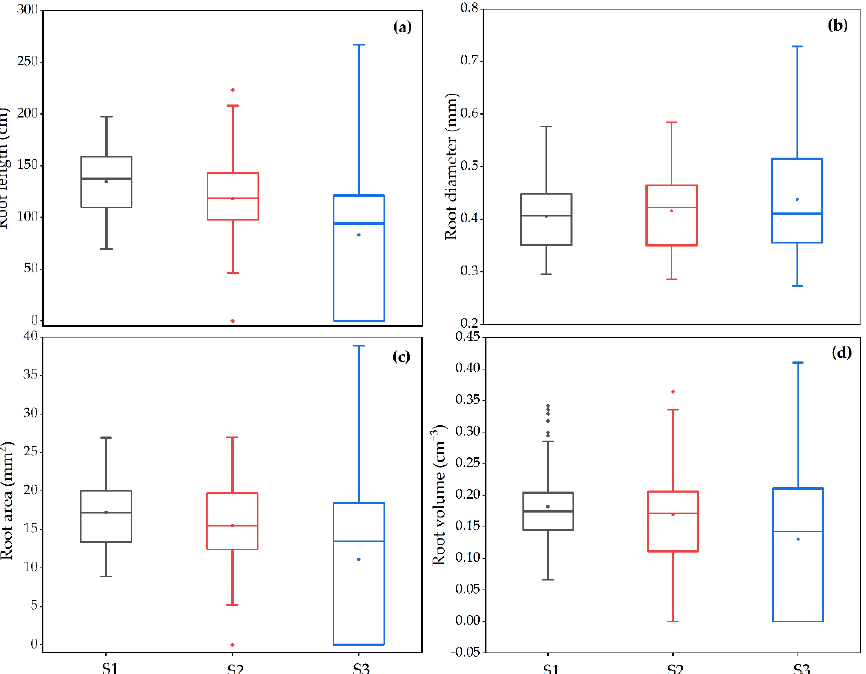
Figure 4. Variations of root phenotypic in the three root sections: ( a ) root length, ( b ) root diameter, ( c ) root area, and ( d ) root volume. Boxplots are limited to the first and third quartiles, and the middle line is the median. Four root traits were plotted. Three root sections: s1, 0–5 cm, colored grey; s2, 5–10 cm, colored red; s3 > 10 cm, colored blue.